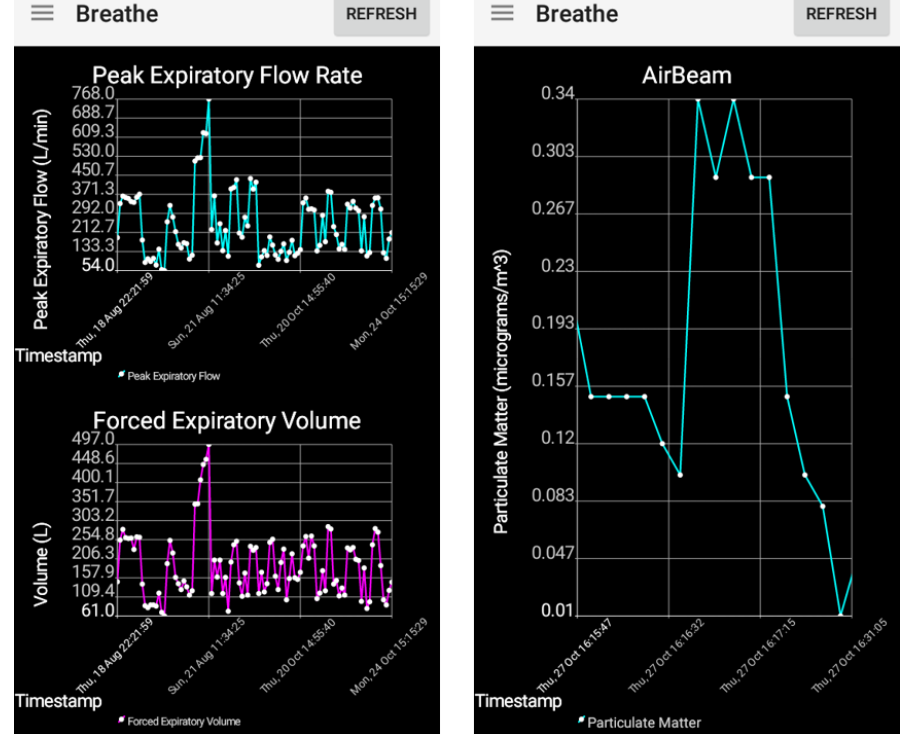
Figure 4. Data trend lines for the spirometer and AirBeam sensors displayed in real time on the smart phone. ( Left ) PEF and FEV1 measurements taken by the spirometer, ( Right ) PM 2.5 measurements taken by the